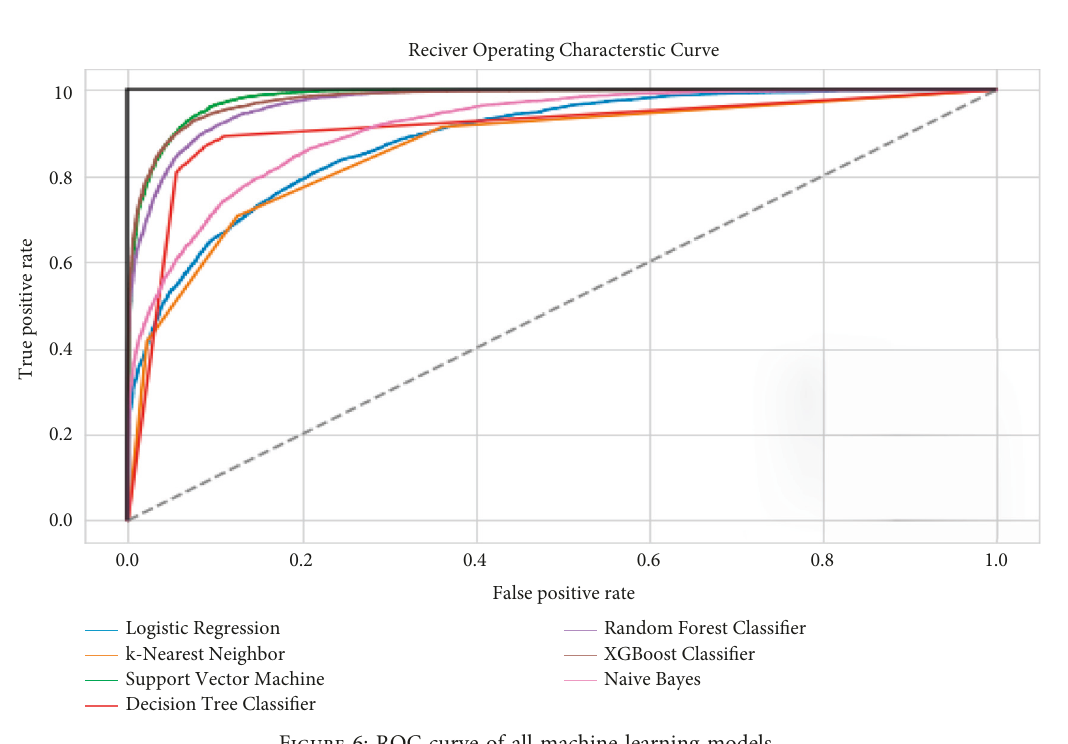
Figure 6: ROC curve of all machine learning models.